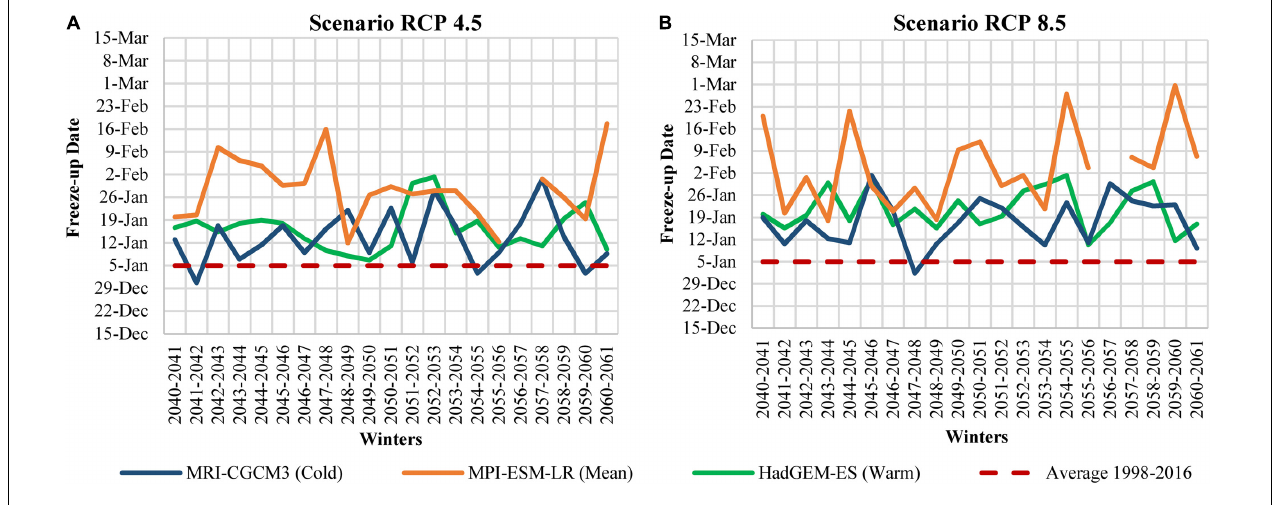
FIGURE 8 | Comparison of freeze-up dates in James Bay for the 2040–2060 period under climatic scenarios RCP4.5 (A) and RCP8.5 (B)